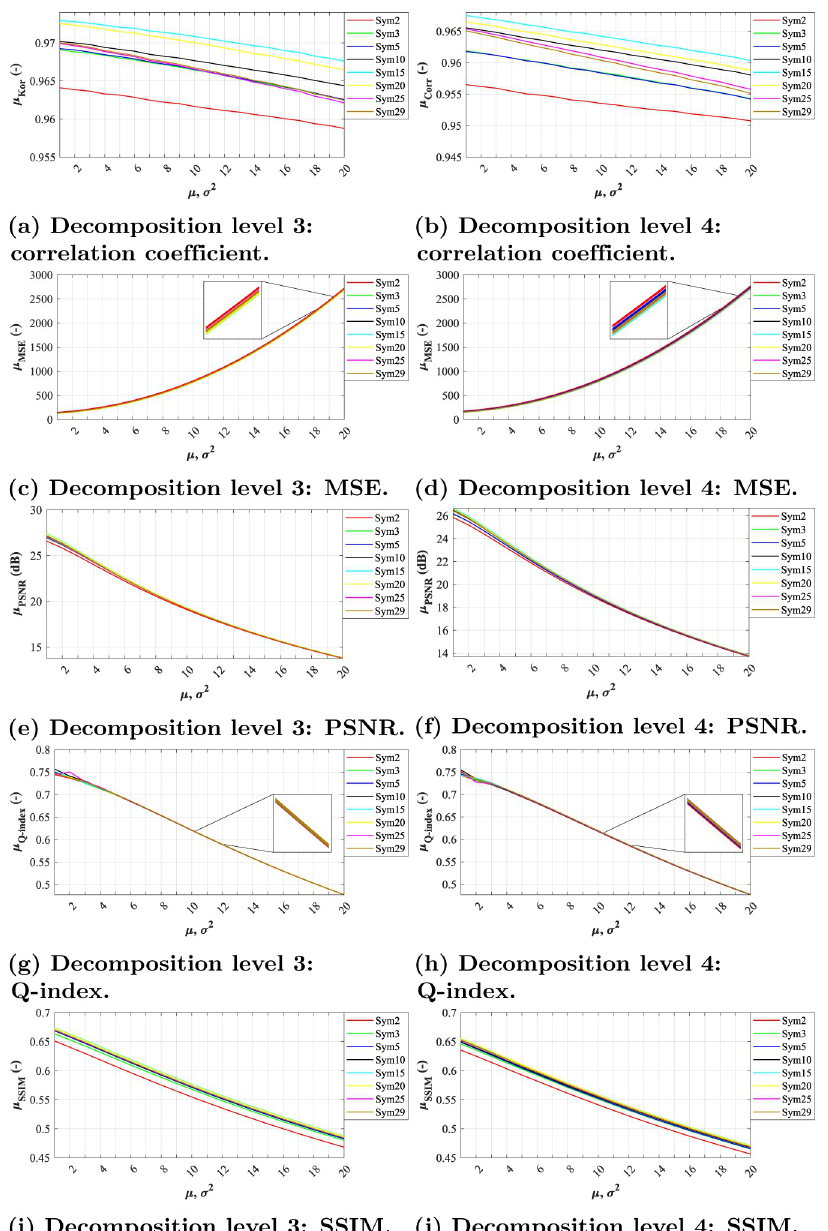
Fig 5. A comparative analysis of Gaussian noise ( σ 2 = 0.01, μ = {0.01, 0.02, ... , 0.20}) for Symlet wavelets with decomposition level 3 and 4. (a) Decomposition level 3: correlation coefficient. (b) Decomposition level 4: correlation coefficient. (c) Decomposition level 3: MSE. (d) Decomposition level 4: MSE. (e) Decomposition level 3: PSNR. (f) Decomposition level 4: PSNR. (g) Decomposition level 3: Q-index. (h) Decomposition level 4: Q-index. (i) Decomposition level 3: SSIM. (j) Decomposition level 4: